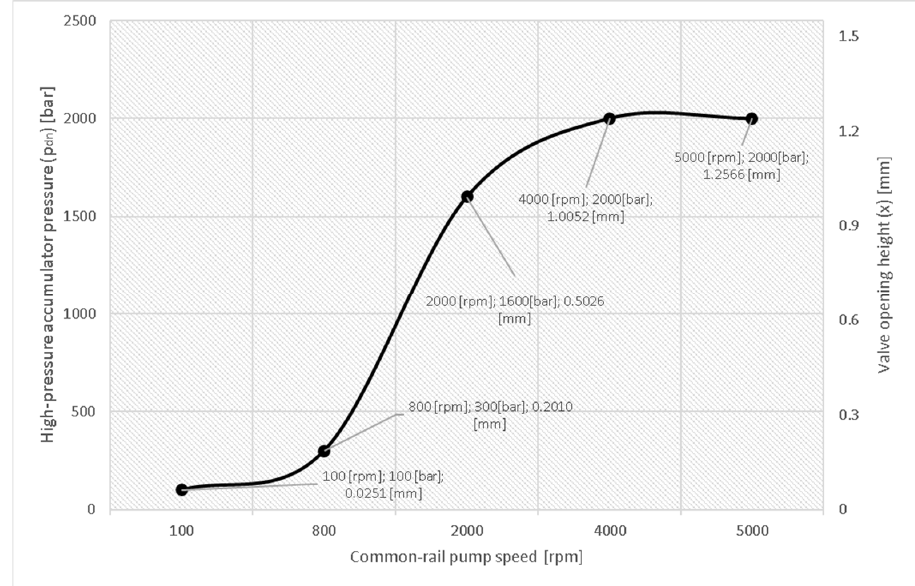
Figure 4. Valve opening according to the pump speed and the pressure supplied.